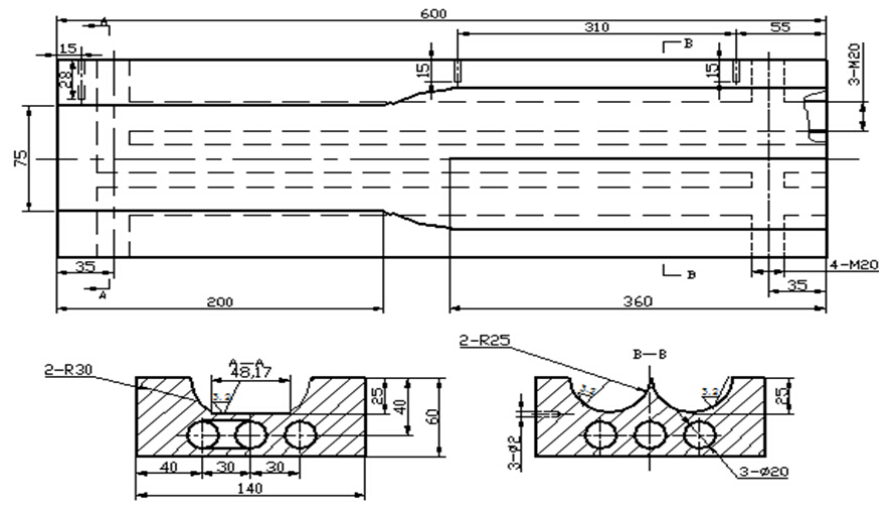
Figure 3. Schematic of fluid director structure.